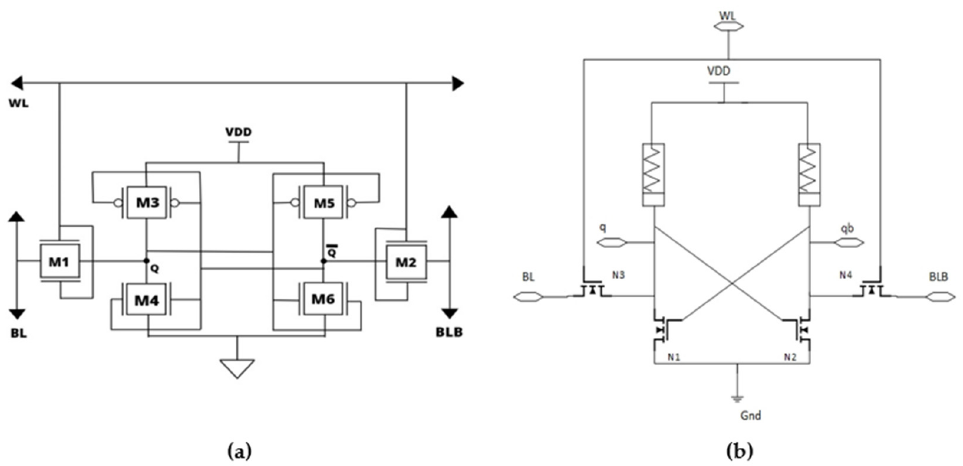
Figure 6. Implementation of 6T ‐ SRAM design using ( a ) FinFET [12]. ( b ) Hybrid MOS–Memristor [22]